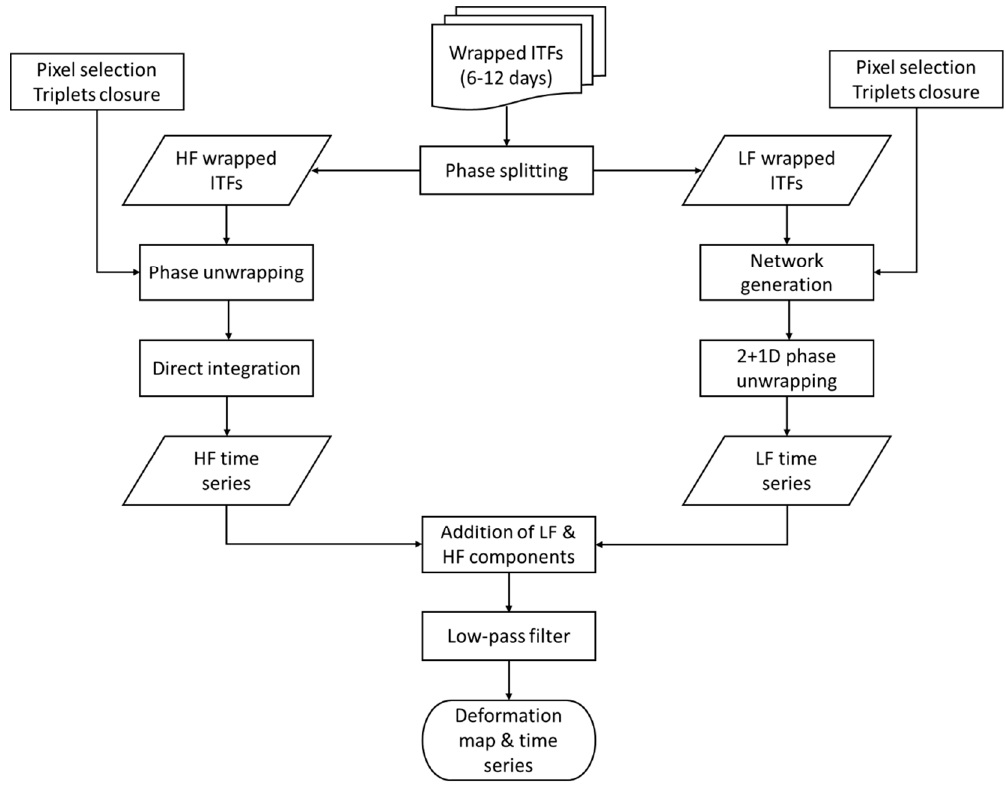
Figure 4. Workflow of the processing approach. ITFs, interferograms; HF, high frequency; LF, low frequency.